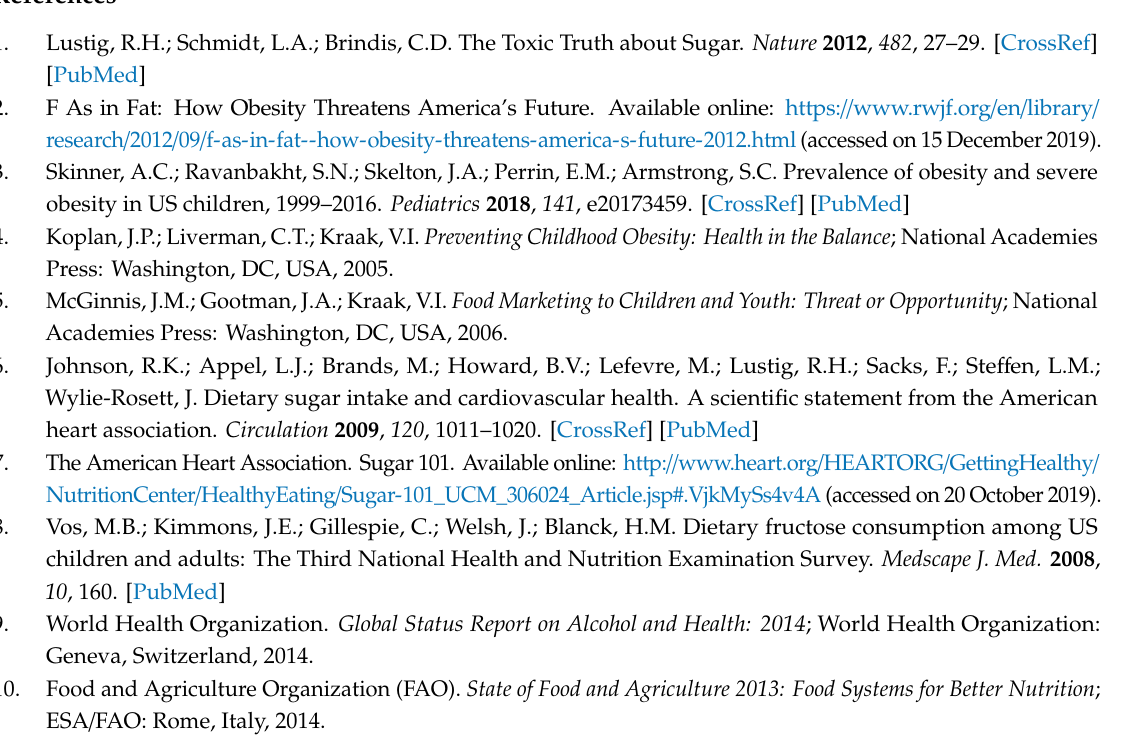
Figure S1: Questions About Drinks; Figure S2: demographic questionnaire; Figure S3: Nutrition Questions; Figure S4: Overall